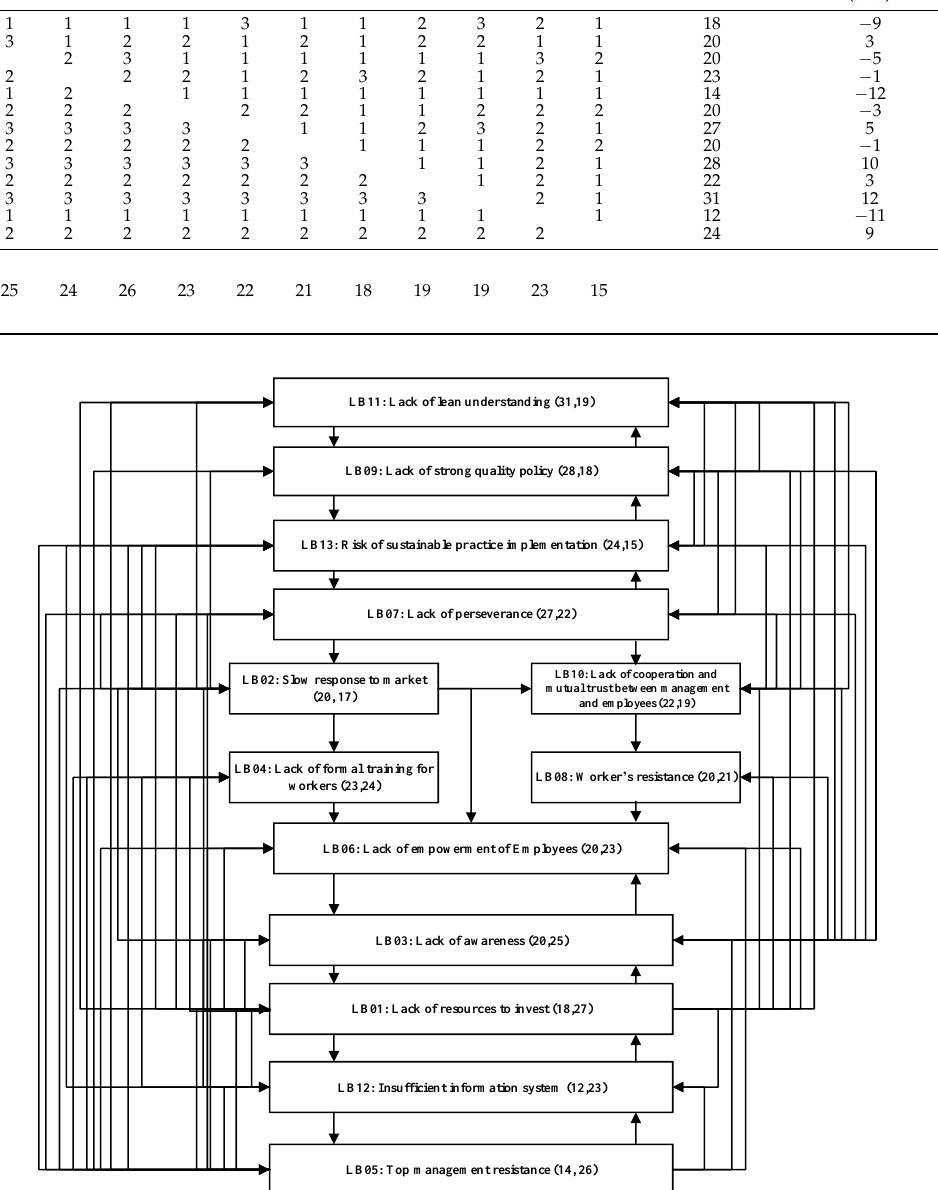
Figure 5. Ranking of LBs using